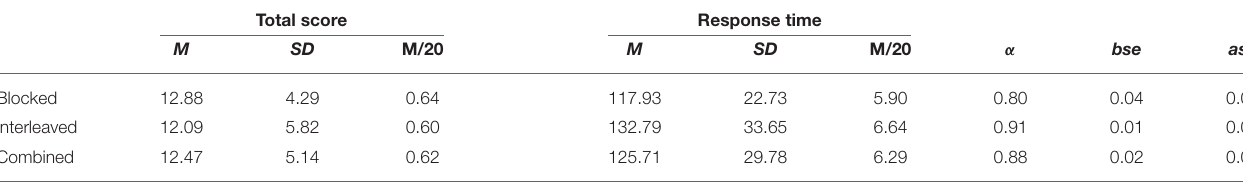
TABLE 3 | Descriptive statistics by form.